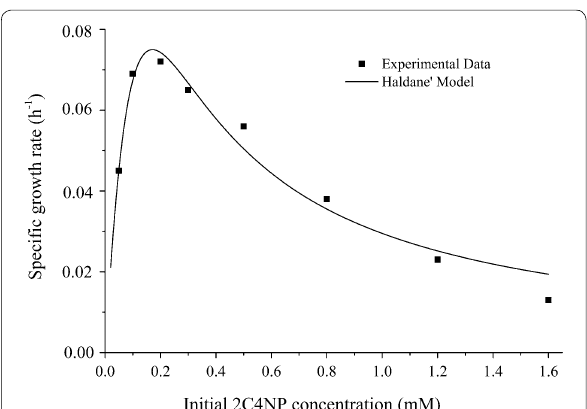
Fig. 3 Experimental and predicted (Haldane’s model) specific growth rates of strain